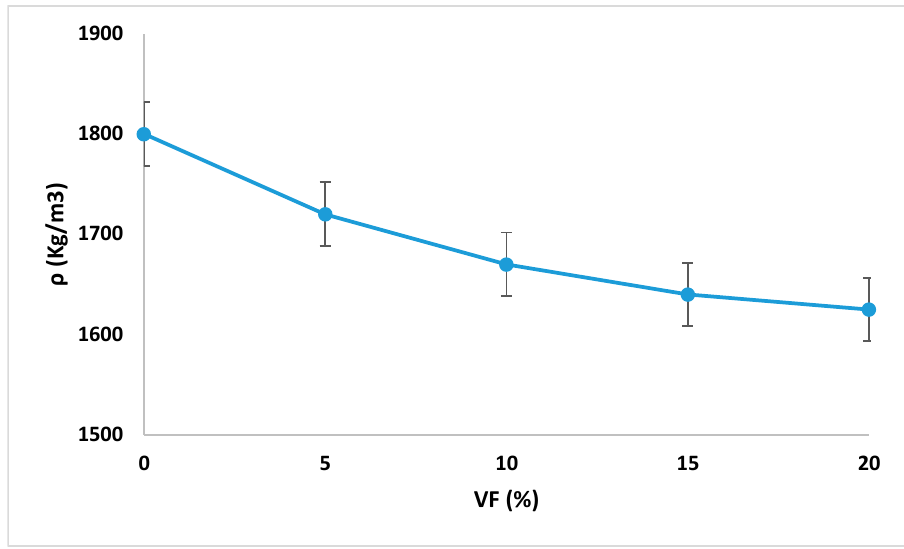
Figure 7. Effect of PO fibers on the density of the mixtures.